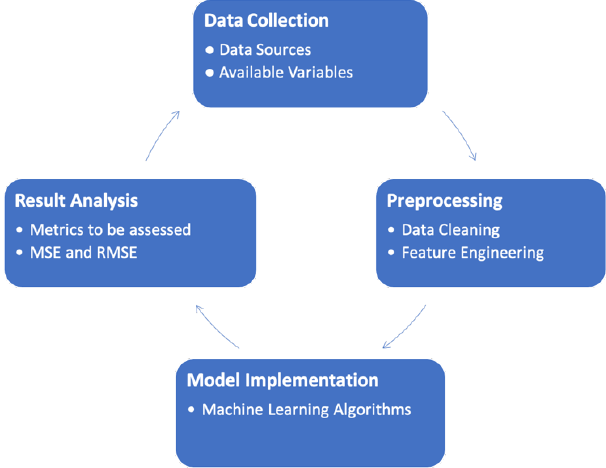
Figure 1. Steps of the implemented methodology.